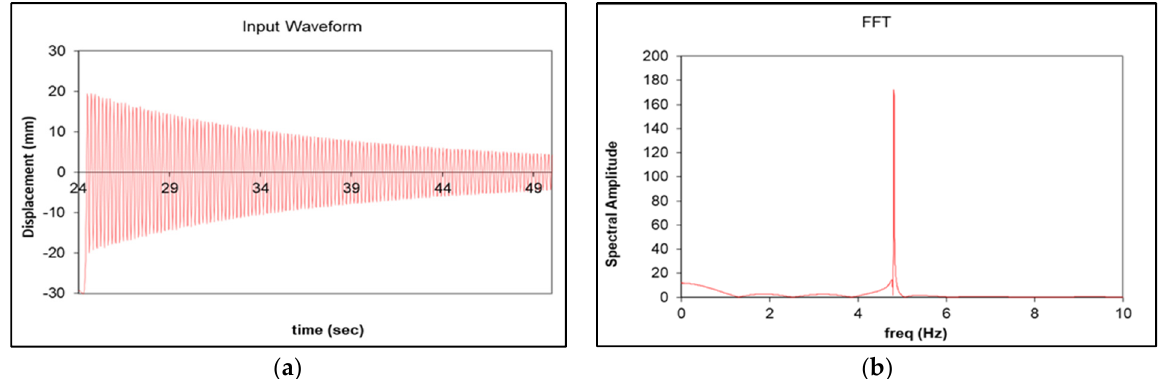
Figure 3. ( a ) The vibration response within the time domain for the brass specimen, ( b ) FFT displaying the 4.8 Hz natural frequency that was determined.